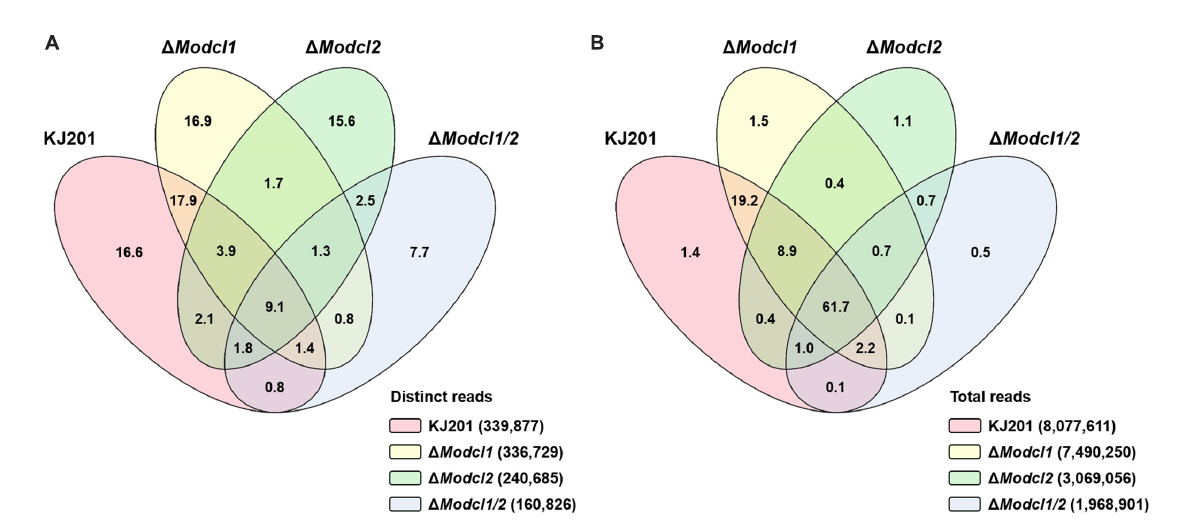
FIGURE1 Venn diagram of sRNAs profiled in the WT and MoDCL mutant libraries. Venn diagram showing the proportions of (A) distinct reads and (B) total reads in the four libraries. Numbers in each section are percentages of read numbers relative to the sum of distinct reads or total reads from the four libraries.